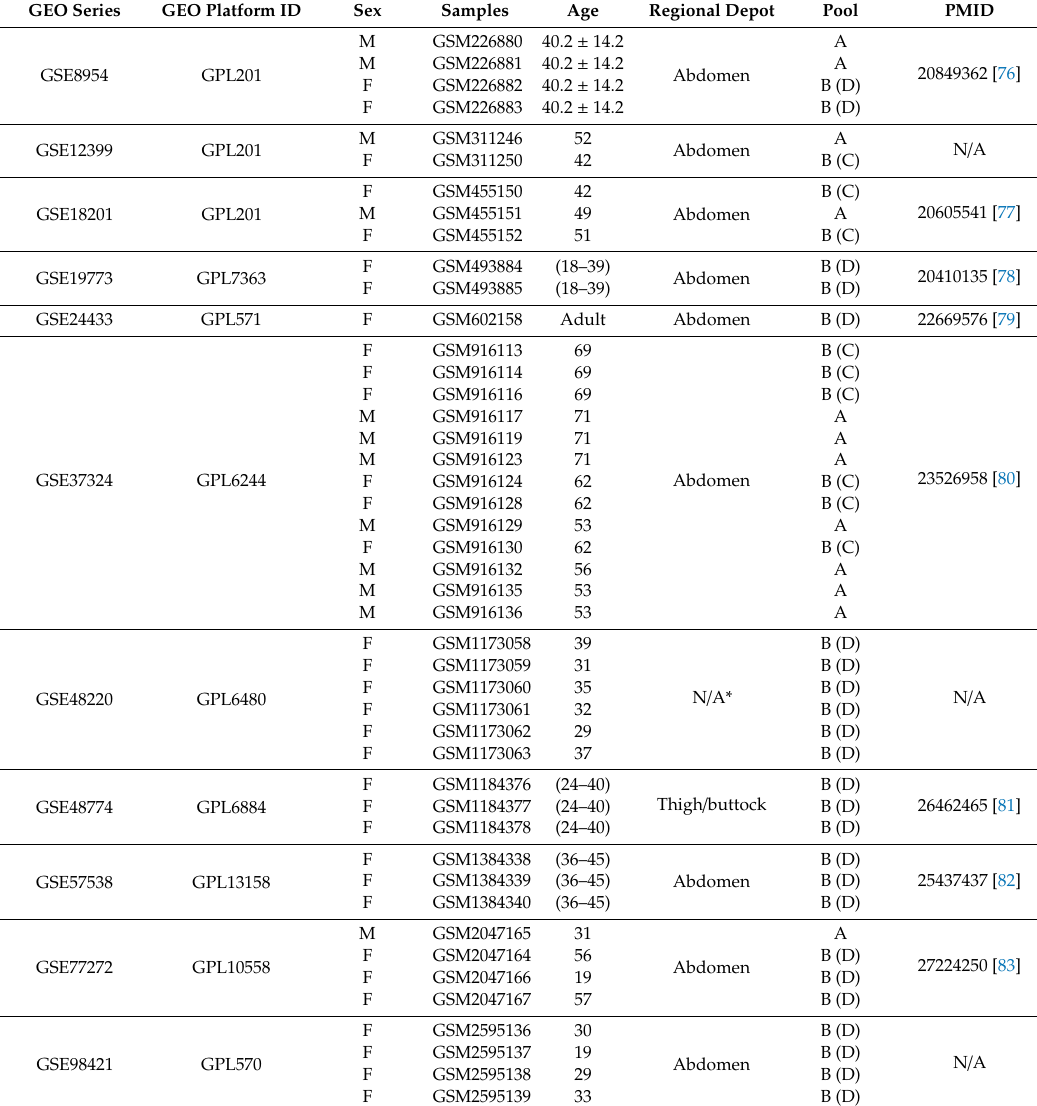
Table 1. Main features of the samples selected for the meta-analyses with TRAM